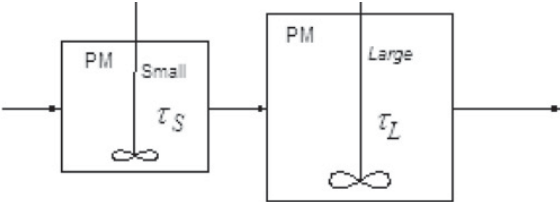
Figure 3. Sensor located on feed box pipe.